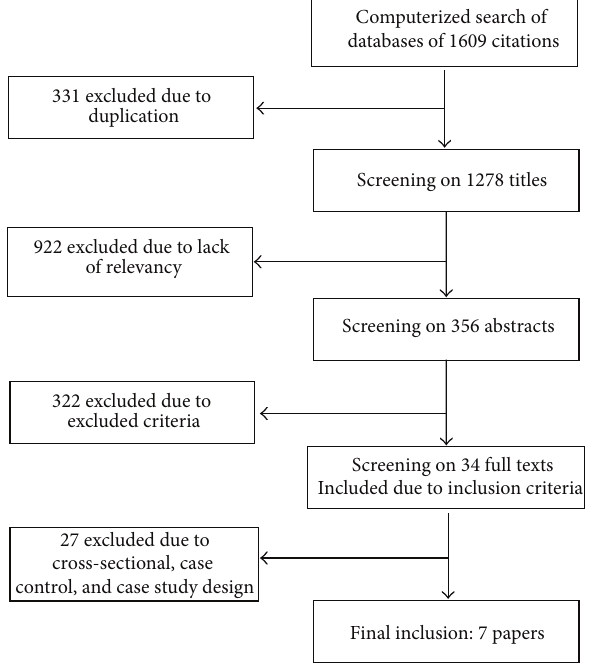
Figure 1: Flowchart of studies selection.